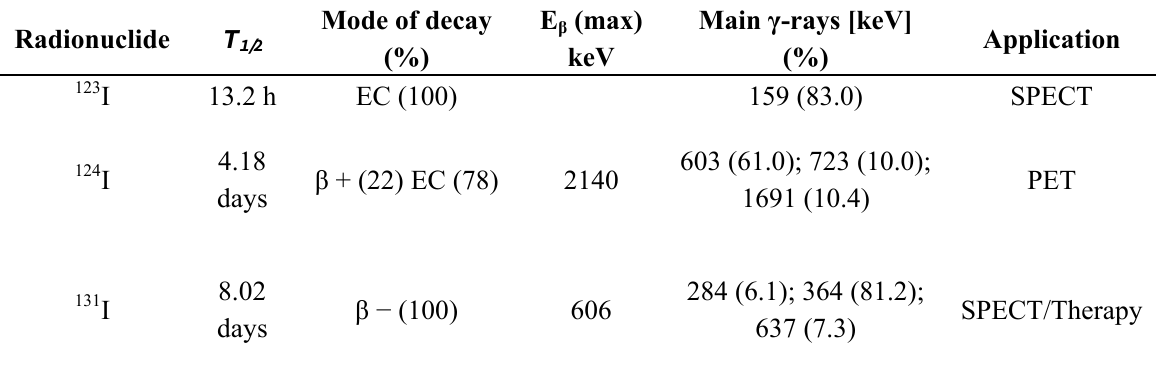
Table 1. Properties of the most common medical iodine isotopes